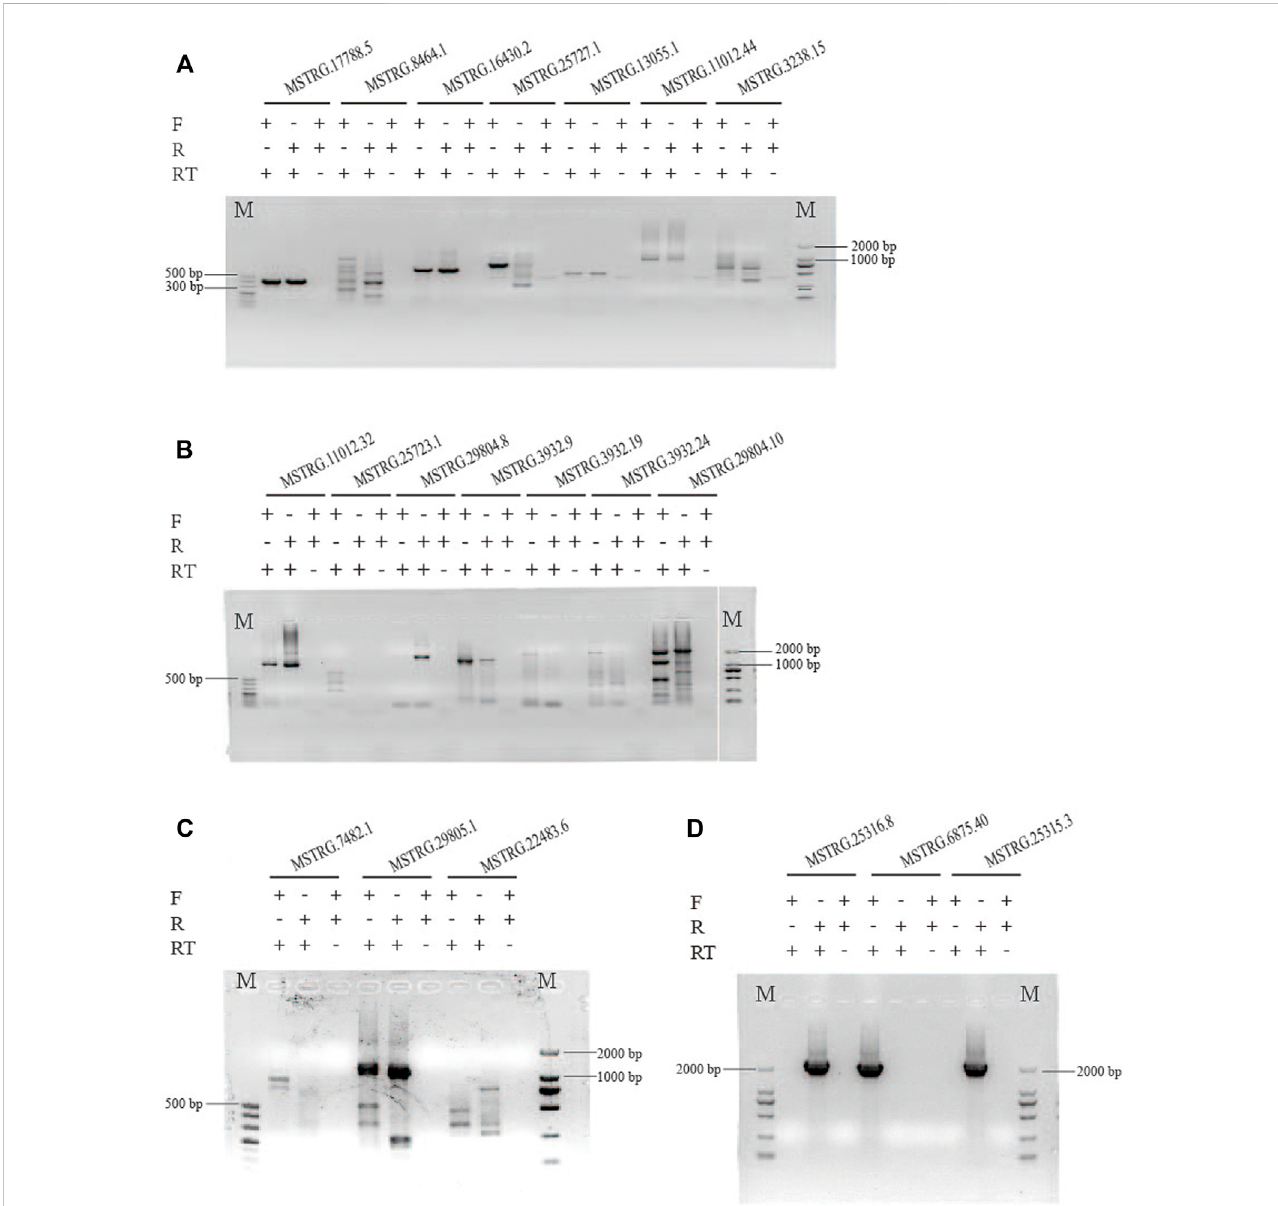
FIGURE 6 Strand-speci fi c PCR of 20 randomly selected lincRNAs to determine transcription orientation. The different electrophoretic bands of lncRNAs with similar PCR product size were shown in (A – D) . The results indicated that 13 lincRNAs are strand-speci fi c, that is, fi ve came out as forward-stranded ( MSTRG.25723.1 , 3932.19 , 3932.24 , 7482.1 , and 6875.40 ) and eight were reverse-stranded ( MSTRG.8464.1 , 25727.1 , 11012.32 , 29804.8 , 29804.10 , 22483.6 , 25315.3 , and 25316.8 . The other seven lincRNAs can be ampli fi ed by both